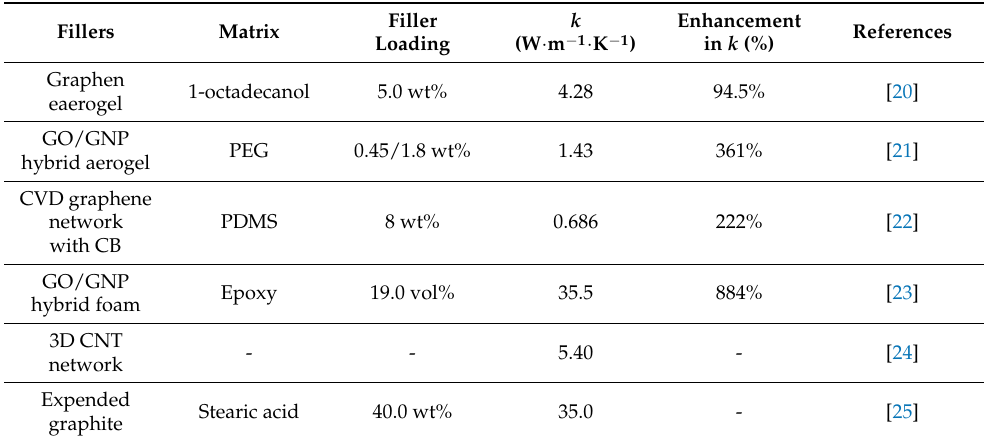
Figure 3. Schematic illustrations of thermal conductance in polymer composites with randomly distributed carbon fillers and a continuous 3D architecture of carbon fillers. Table 1. Thermal conductivity ( k ) values of the various polymer composites with a continuous 3D architecture of carbon